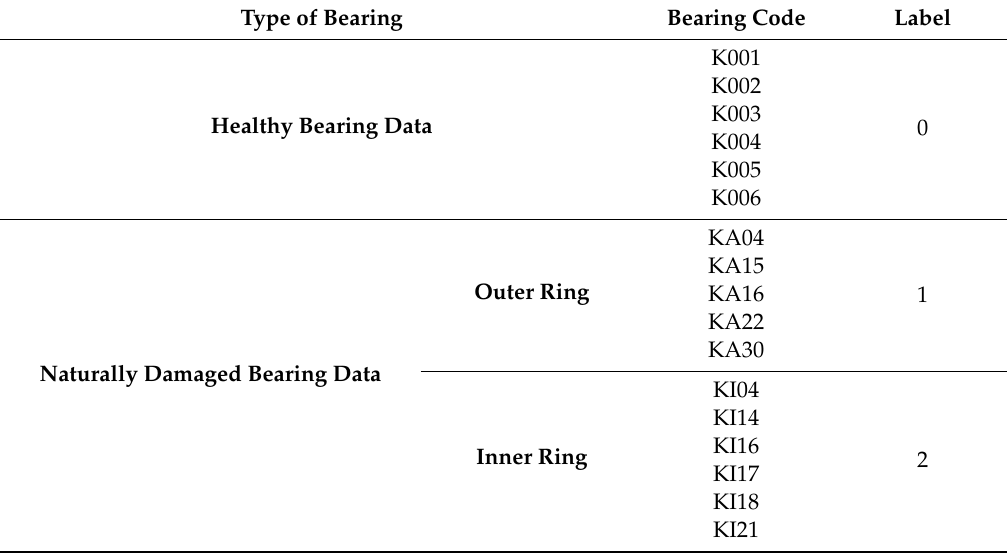
Table 2. Bearing sets for